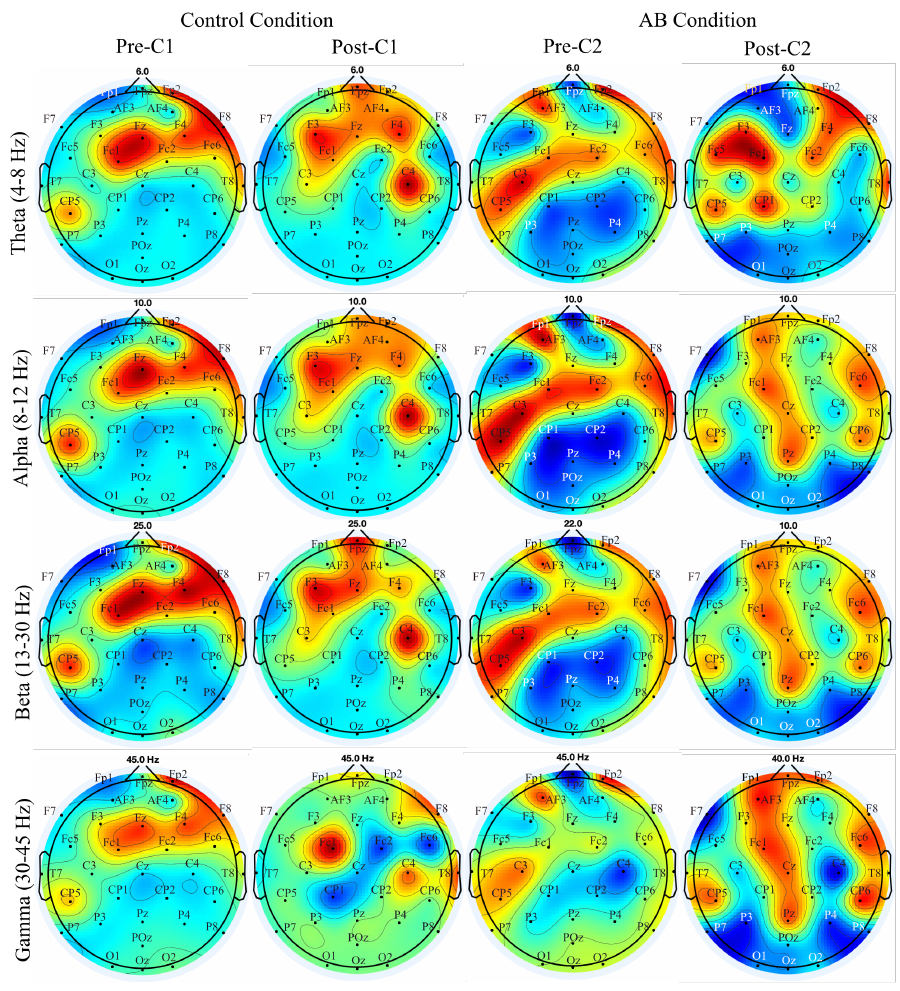
Figure 3. PSD difference map for each frequency band and each condition.